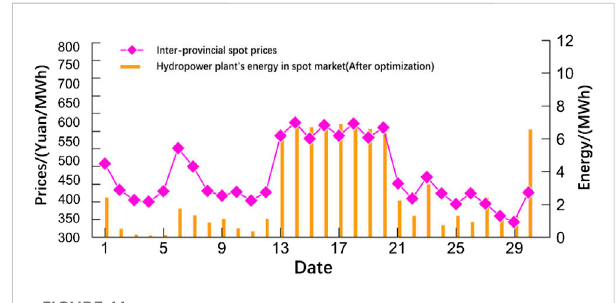
FIGURE 11 Matchinganalysis ofenergyallocationafter optimizationininter- provincial spot and the spot prices.